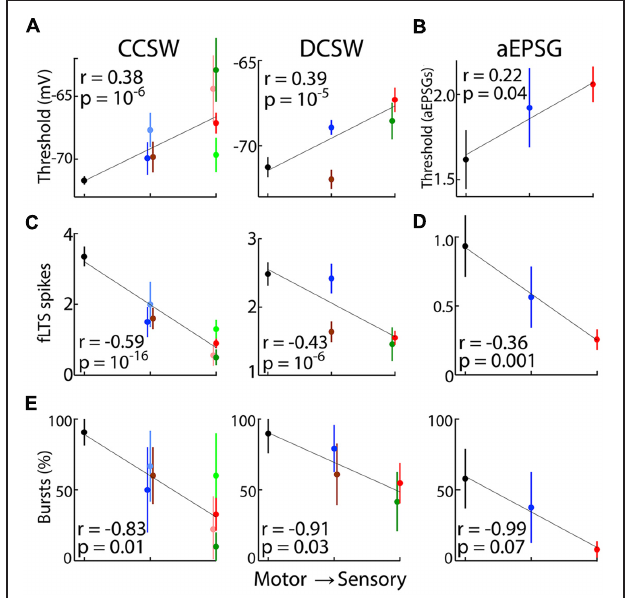
FIGURE 9 | Correlation of TtCC-mediated responses with distance from motor output. Population mean responses after 800 ms or more near − 80 mV as a function of ‘relative distance from motor output’ of thalamic nuclei as ranked according to scheme 1 ( Table 3 ). Although means are shown, lines were fit and Pearson’s correlation was performed across all individual neuronal responses, except in (E) . Data in (A,C) is also shown in Figure 6 . (A) Effective voltage thresholds (mean ± SEM) for evoking spikes in CCSW (left) and DCSW protocols (middle). Data points are slightly offset horizontally to avoid overlap. (B) The number of aEPSG (1, 2, or 4 in each cell) required to evoke one or more spikes after 800 ms near − 80 mV (used as an alternative to voltage thresholds, which were difficult to measure in aEPSG experiments). (C) Spike count in response to the fLTS in CCSW (left) and DCSW (right) protocols. (D) Spike count in response to one aEPSG. (E) Percentage of neurons having a burst in CCSW (left), DCSW (middle) and aEPSG protocols (right), with ‘bursts’ defined as in Results. Unlike (A–D) correlations were across populations since burst incidence is not defined for single neurons. Vertical bars indicate 95% confidence intervals based on a binomial model, whereas standard error of the mean is shown in (A–D) .